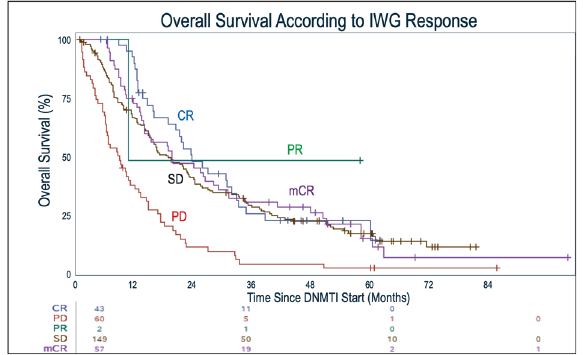
Fig. 2 Overall survival from the time of therapy initial until death or last known alive, among patients treated with DNMTI therapy. Survival is shown according to the best overall response on DNMTI therapy (IWG 2006 criteria). Patients with CR as the BOR had prolonged survival compared to mCR, SD, and PD ( p < 0.001).